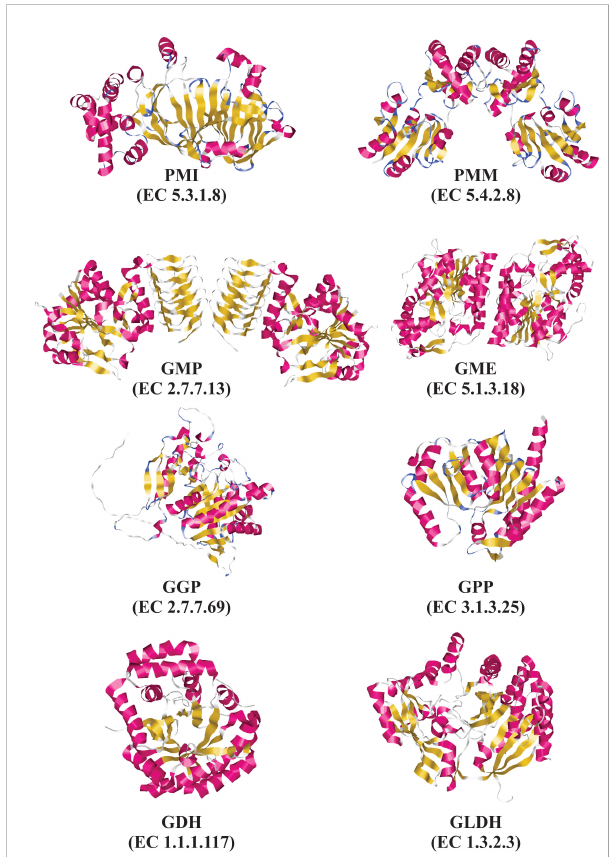
FIGURE 3 Experimental and predicted tridimensional structures of enzymes from the L-galactose pathway for AsA biosynthesis. Experimentally determined tridimensional structures by X-ray diffraction for the following enzymes: GMP from Arabidopsis thaliana “ thale cress ” (PDB code: 7X8K), GME from Arabidopsis thaliana “ thale cress ” (PDB code: 2C54), GDH from Spinacia oleracea “ spinach ” (PDB code: 7SMI), and GLDH from Myrciaria dubia “ camu-camu ” (PDB code: 7SML). Predicted tridimensional structures determined by using SWISS-MODEL for the following enzyme: PMI from Arabidopsis thaliana using as a template the three-dimensional structure of PMI from Candida albicans (PDB code 1PMI). Predicted tridimensional structures determined by using AlphaFold for the following enzymes: GGP from Arabidopsis thaliana (AlphaFoldDB: Q8RWE8), and GPP from Arabidopsis thaliana (AlphaFoldDB: Q9M8S8). Tridimensional structures were drawn using RasMol